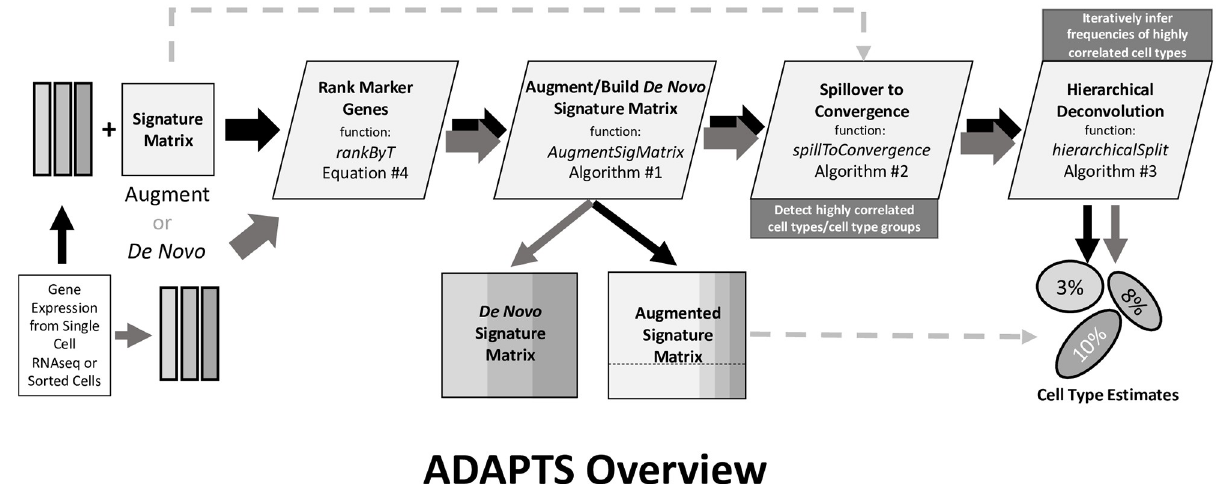
Fig 1. Overview of ADAPTS modules. New gene expression data from cell types (e.g. from a tumor microenvironment) will be used to construct a new signature matrix de novo or by augmenting an existing signature matrix. First ADAPTS will rank marker genes for the cell types using the function rankByT described in Eq 4. Then ADAPTS adds marker genes in rank order using the function AugmentSigMatrix as described in Algorithm 1 resulting in a new signature matrix. This matrix may be tested for spillover between cell types using the function spillToConvergence described in Algorithm 2. Finally, ADAPTS separates cell types with heavy spillover using the hierarchical deconvolution function hierarchicalSplit described in Algorithm 3 to estimate the percentage of cell types present in bulk gene expression data.